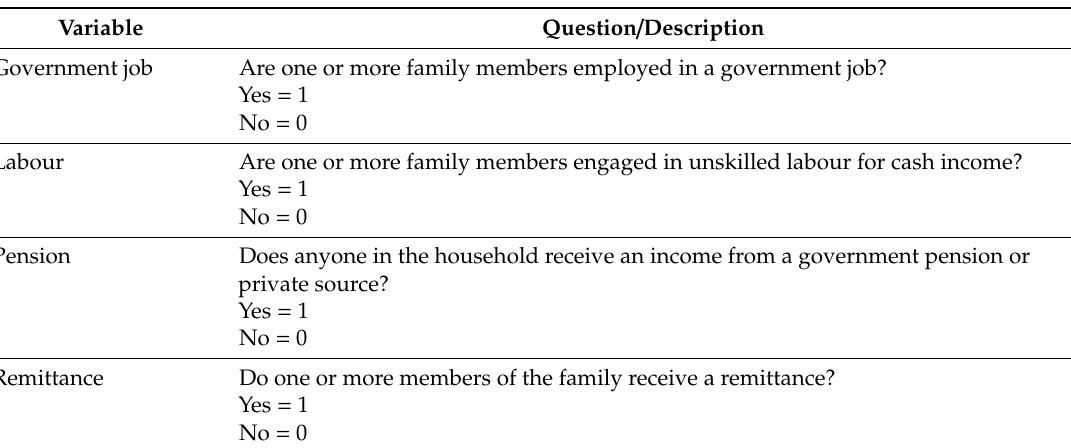
Table 3. List of independent